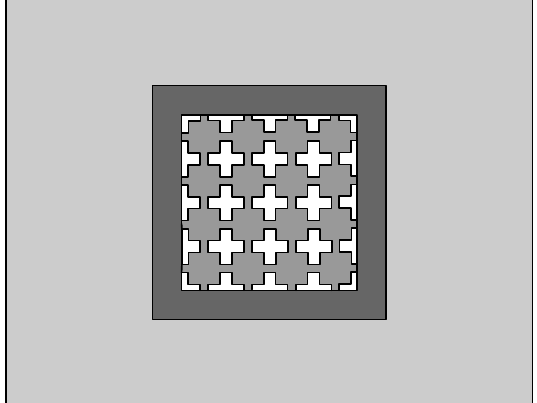
Figure 6. The domain of benchmark problem: conduction domain Ω C is filled with quadratic wires connected by thin bridges.